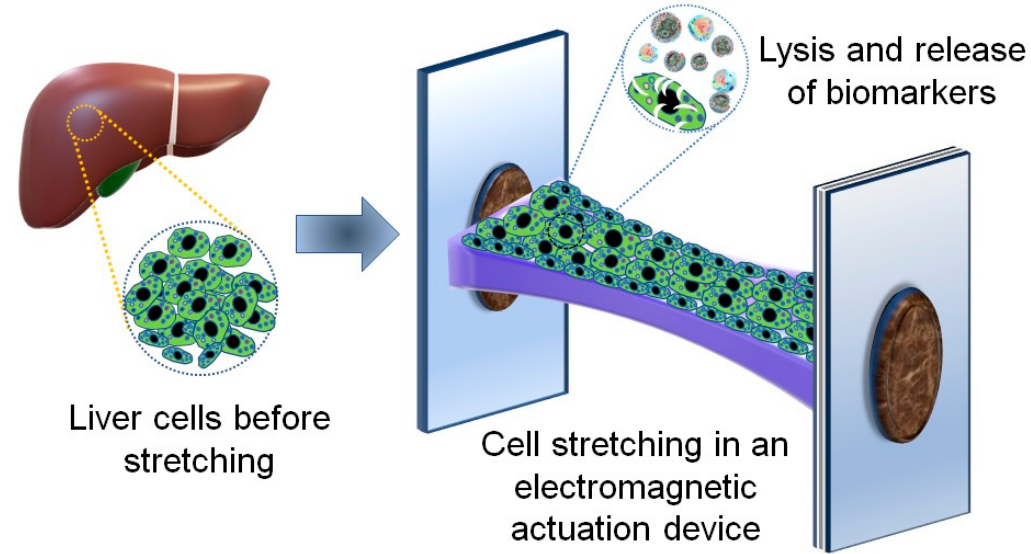
Figure 1. Graphic illustration of the procedure used for the quantification of protein biomarkers (RhoA, Rac1 and ALP) in liver cancer cells. The liver cancer cells were seeded once the deformable membrane was bonded on a magnetically actuated polydimethylsiloxane (PDMS) support. The PDMS parts device was then inserted on the cell stretching platform, followed by the application of the cyclic mechanical strain. The stretched cells were lysed chemically, and the supernatant was collected for the quantification of the released protein biomarkers. The levels of the markers released before and after stretching were quantified by using ELISA.